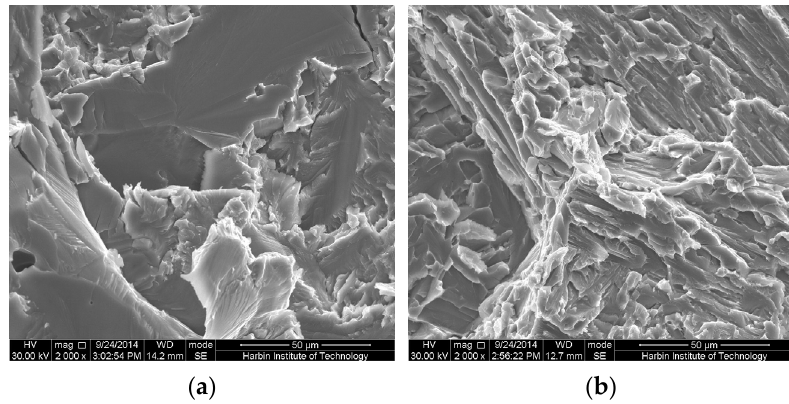
Figure 6. SEM images of the fracture surfaces for samples after tensile: ( a ) as ‐ sintered alloy and ( b ) as ‐ processed alloy.